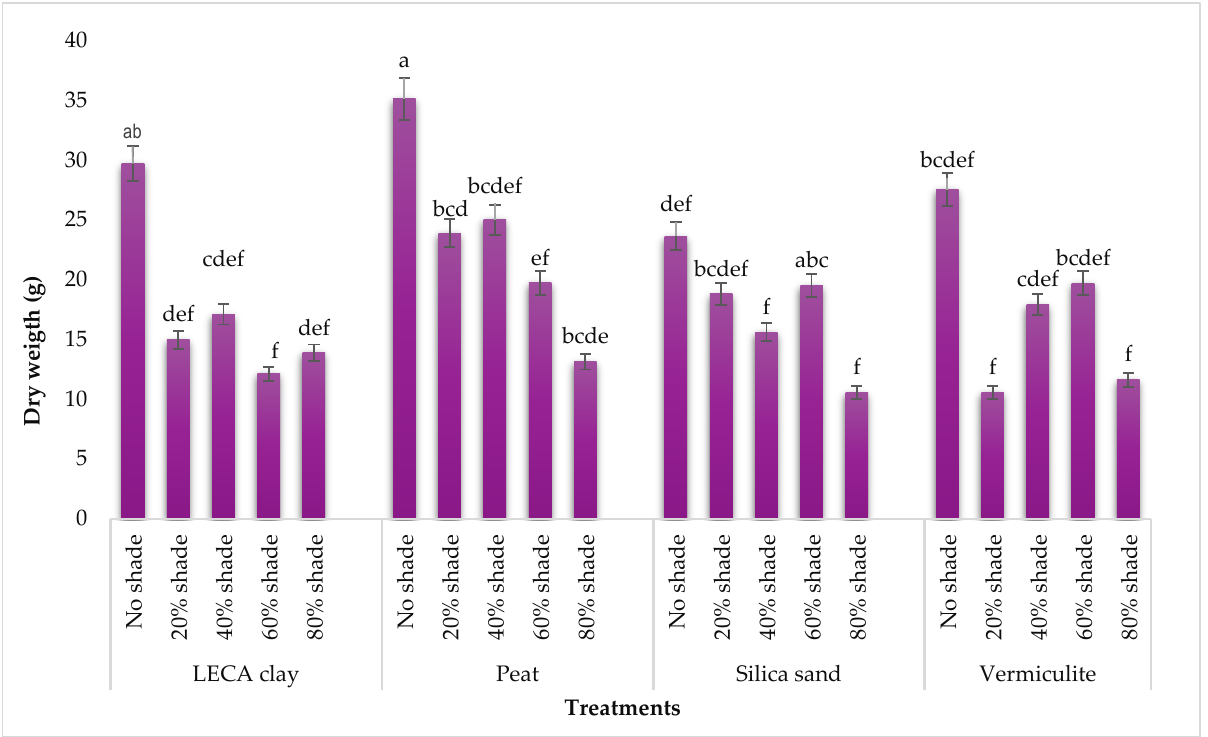
Figure 5. The effect of different growth media and different shade levels on the dry weight of T. divaricata . Means in the same column followed by the same letter did not differ by Tukey’s test ( p > 0.05).